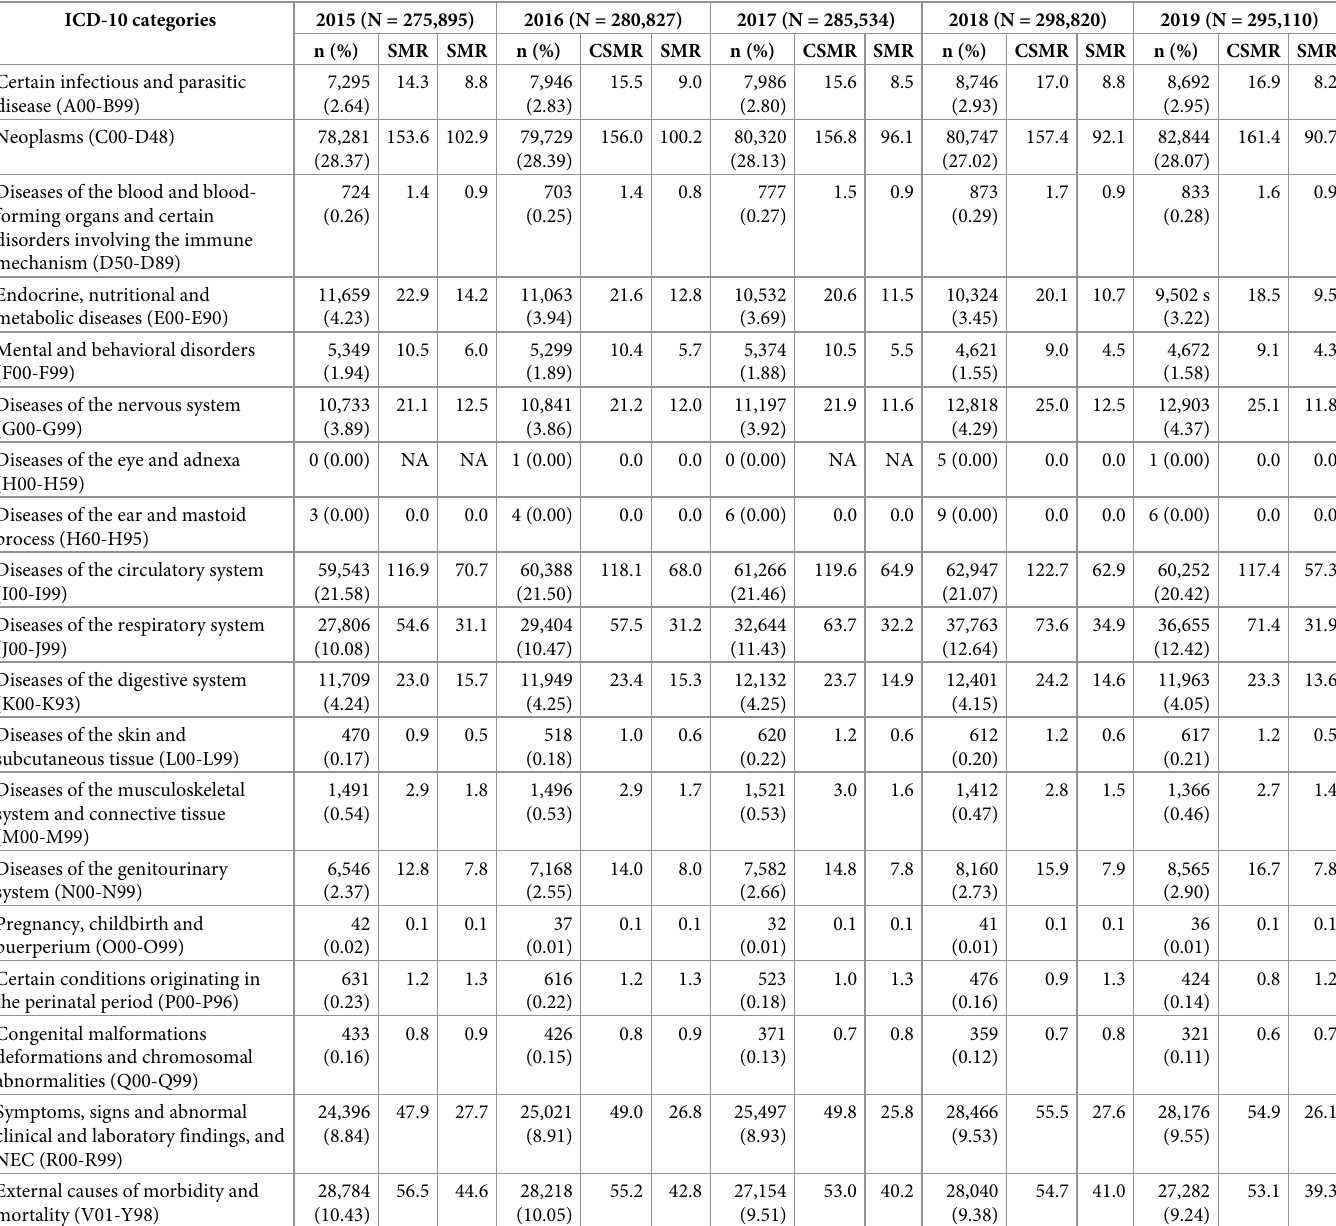
Table 4. Causes of death among the general population based on ICD-10 codes from 2015 to